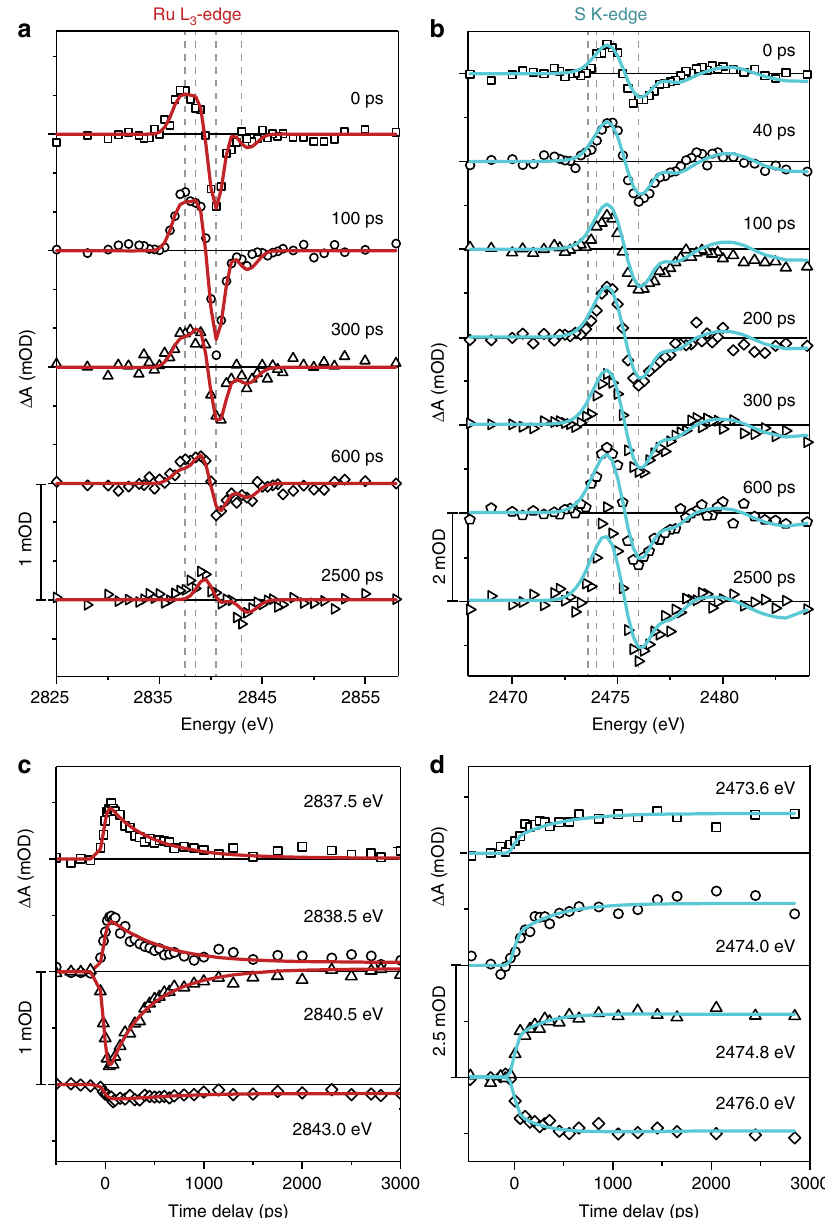
Fig. 4 Complete TR-XAS data measured for [Ru(bpy) 2 (pyESO)] 2 + and global fi t results. Measured TR-XAS data (scattered) is overlaid with the least- square fi t to the kinetic model described in the text (solid lines). a , b Differential absorption spectra at several fi xed time-delays at the Ru L 3 -edge ( a ) and S K-edge ( b ). Vertical lines indicate the energies monitored as a function of time-delay. c , d Time-delay scans at several Ru L 3 -edge ( c ) and S K-edge ( d ) fi xed